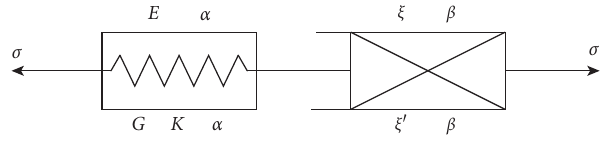
Figure 3: New Maxwell creep